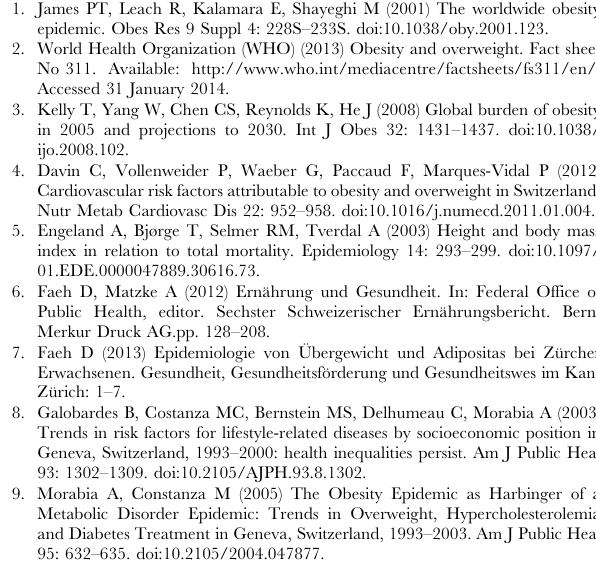
Figure S1 Mean BMI of Swiss conscripts across year of birth and professional status (first panel from top), tertiles of median Swiss-SEP index of postcode of residence (second panel), degree of urbanicity of community of residence (third panel) and region of residence (fourth panel). (TIFF) Figure S2 Mean BMI of 19-year-old Swiss conscripts across conscription years 1950–2012. Data for the period 1950–2003 come from Staub (2010); data for the 2004–2012 period come from the conscript records of 19-year-olds in the current study population. (TIFF) Table S1 Distribution of the Swiss conscripts across year of birth and age at conscription compared with the population count of 17- year-old Swiss residents in a given year and the total number of live births in a given year. Figures in bold refer to the birth years corresponding to the ones used in this